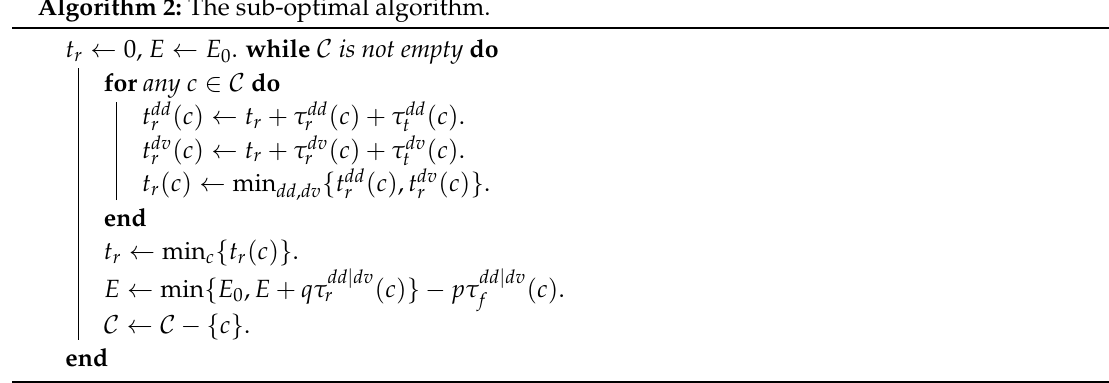
Algorithm 2: The sub-optimal